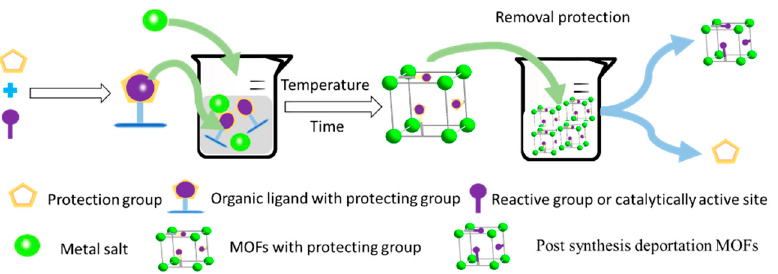
Figure 8. Schematic diagram for the post-synthesis deportation of MOFs.